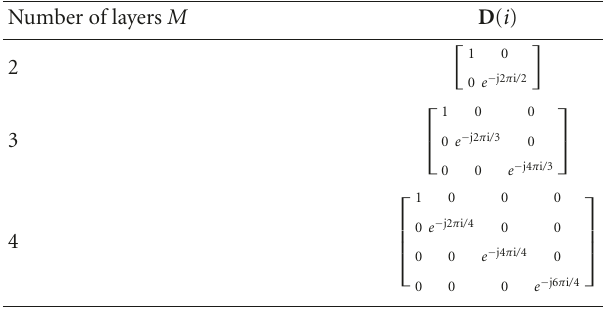
Table 5: Large delay CDD matrix D ( i ) .